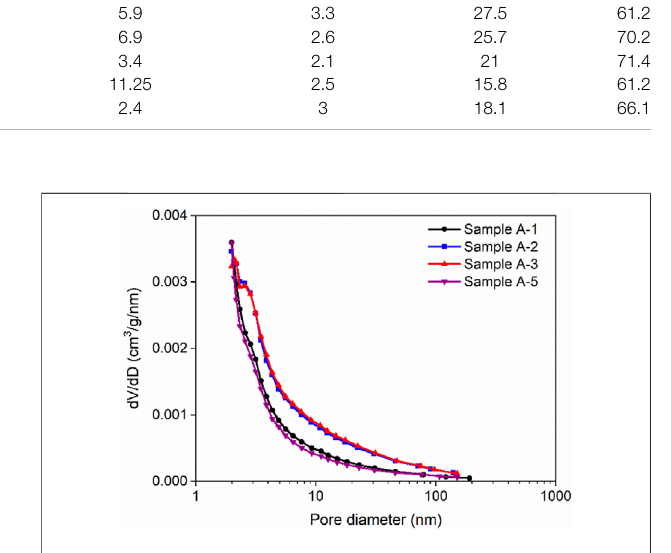
FIGURE 5 | Pore size distribution of representative shale samples from well Anye A well platform derived from nitrogen adsorption isotherms.